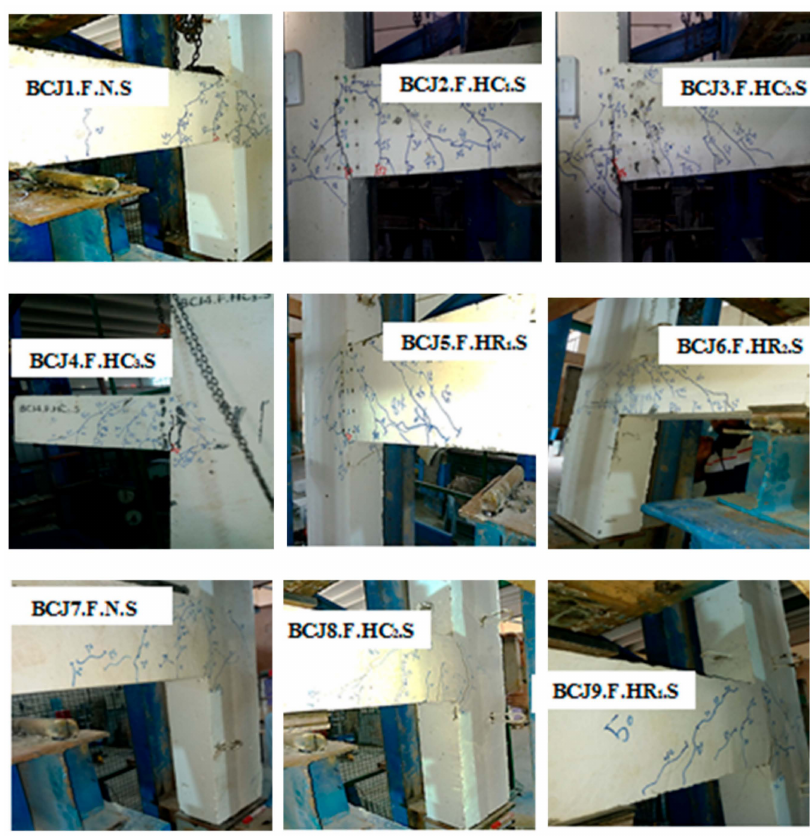
Figure 7. Modes of failure and cracking patterns of all specimens.